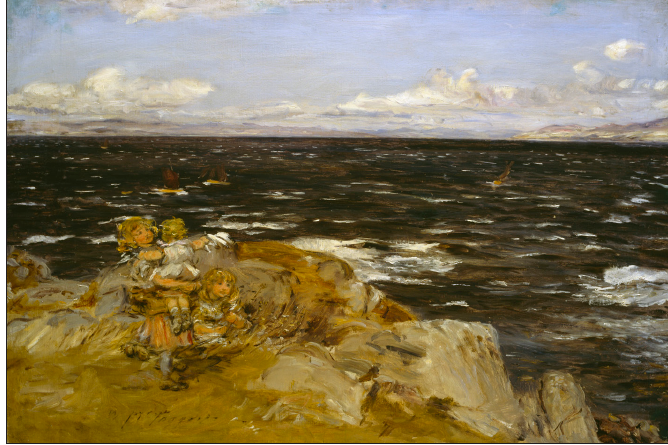
Fig. 3 : William McTaggart, North Wind, Kilbrannen Sound , 1883, oil on canvas, 81.3 × 121.9 cm, Glasgow Museums. Bequeathed by William McInnes, 1944,